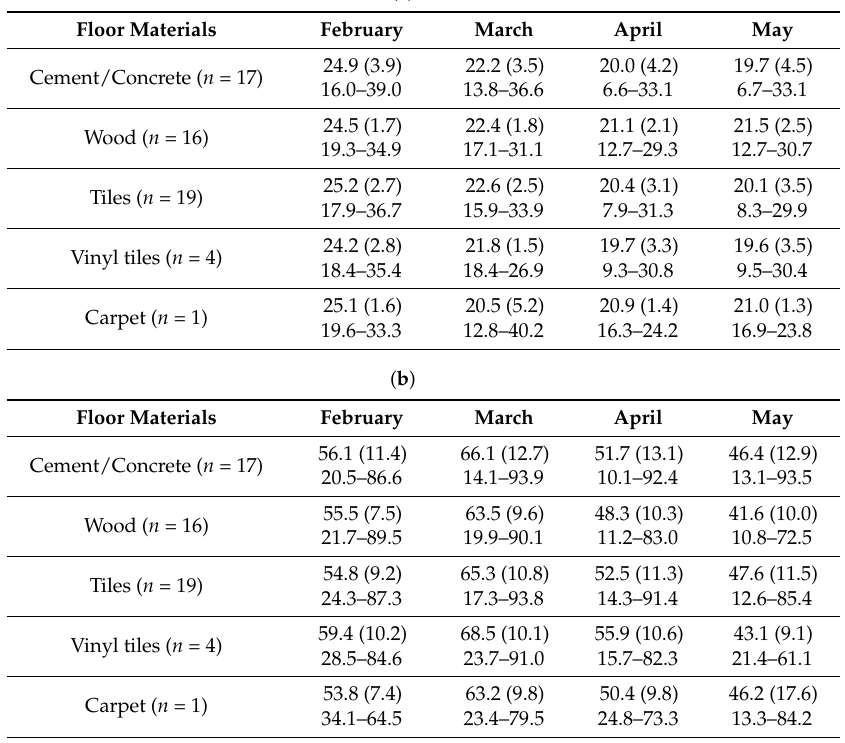
Table 6. ( a ) Monthly indoor temperatures (in ◦ C) by floor material (means and standard deviations, ranges below); ( b ) Monthly indoor humidity (%) by floor material (means and standard deviations, ranges below).